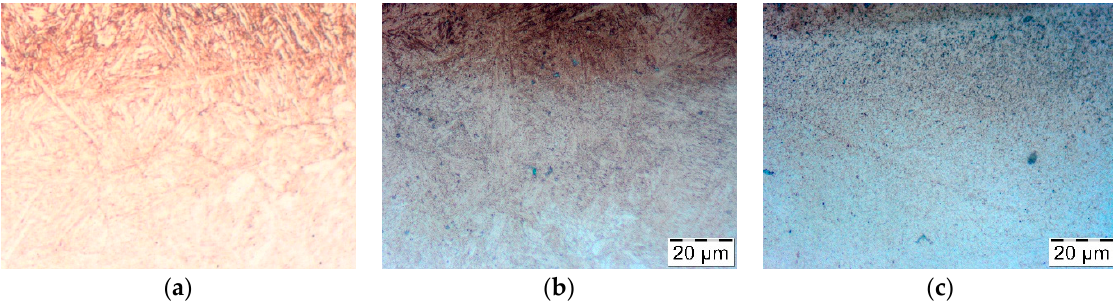
Figure 11. The microstructure at a depth of approximately 0.2 mm (below the nitrided layer) ( a ) as delivered, ( b ) held at 625 °C for 2 h ( c ) after 3000 forging cycles at approximately 625 °C.